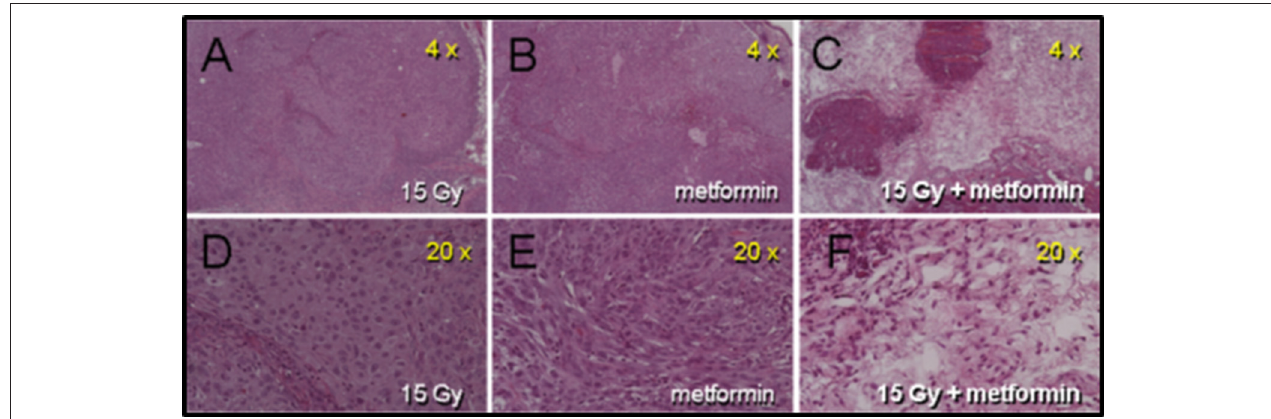
FIGURE 2 | Histologic damage seen in intra-dermally (i.d.) grown A549 tumors receiving metformin 1h after 15Gy. Panels (A–C) are from mice receiving 15Gy, metformin (200 mg/kg) and combined radiation and drug, respectively. Panels (D–F) are the same tumor sections at higher magnification. Tumors were removed 1h after metformin (2h after radiation). Only tumors from mice receiving the combination of drug and radiation show frank damage.